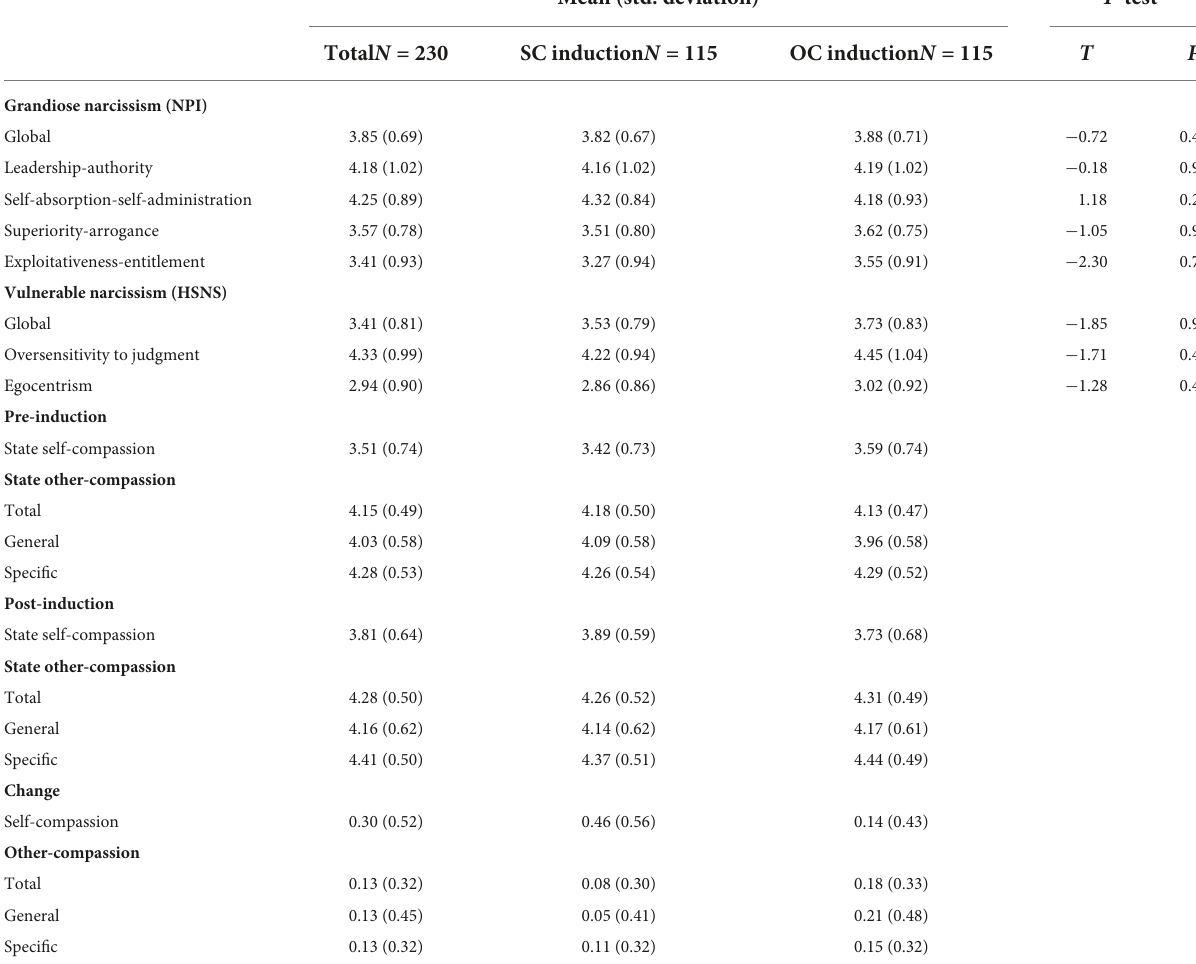
Mean (std. deviation)